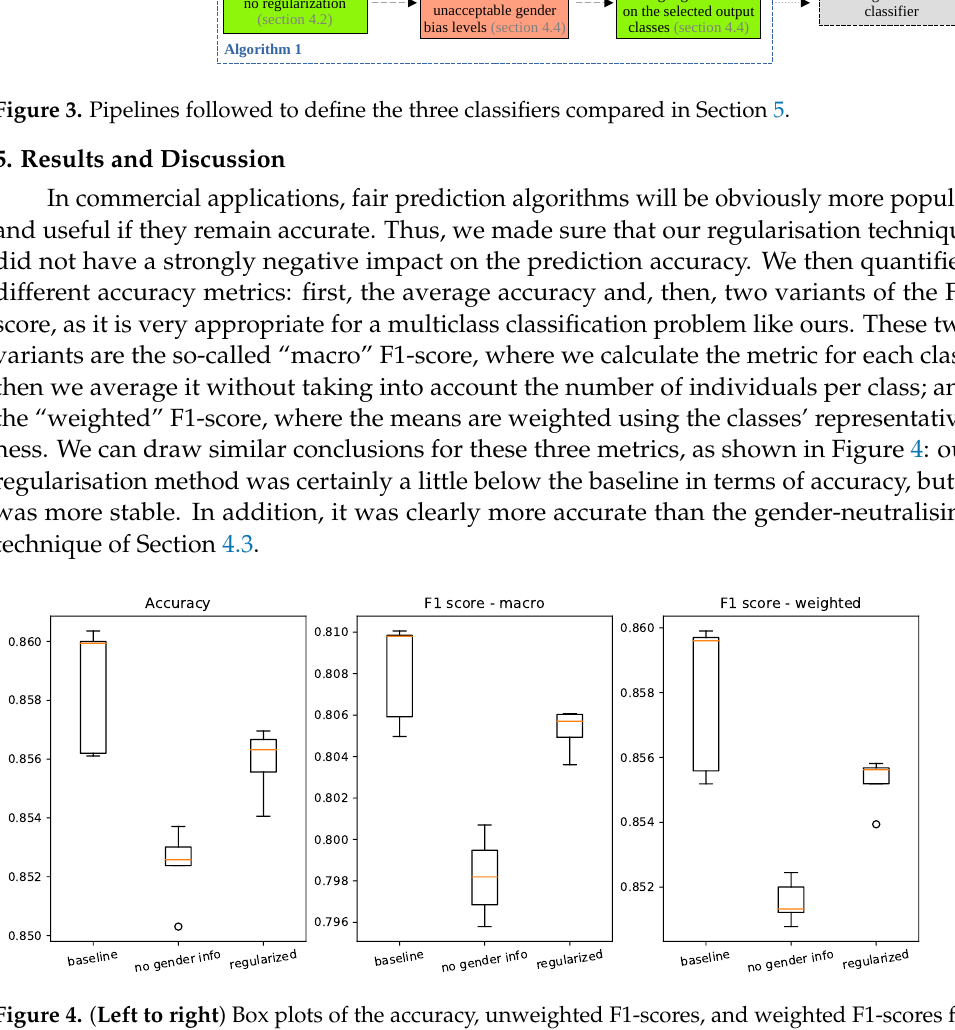
Figure 4. ( Left to right ) Box plots of the accuracy, unweighted F1-scores, and weighted F1-scores for the baseline models with raw biographies, the baseline models with unbiased biographies, and the regularised models with raw